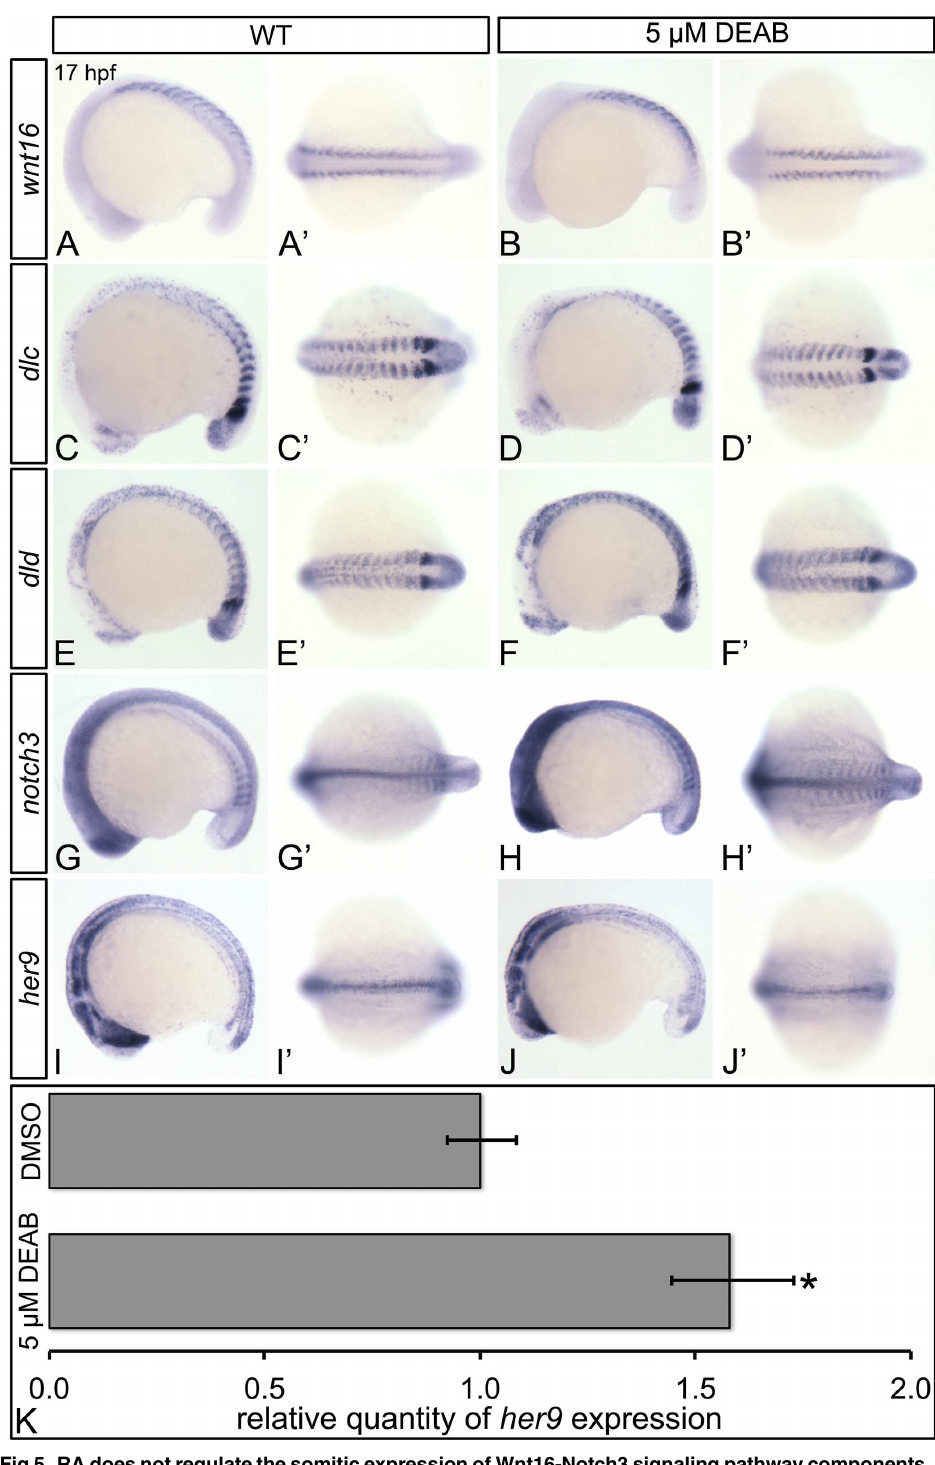
Fig 5. RA does not regulate the somitic expression of Wnt16-Notch3 signaling pathway components. Shown are representative 17 hpf embryos following in situ hybridization analyses(A-J’). Lateral view (A-J) or dorsal view (A’-J’) of gene expressionis shown with anterior orientedto the left. A’-J’ represent different views of the embryos shown in A-J. Compared to DMSO-treated controls (A, A’, C, C’, E, E’, G, G’), DEAB-treated embryos exhibit normalsomitic expressionlevels of wnt16 (B, B’), and dlc (D, D’), mildly increased dld